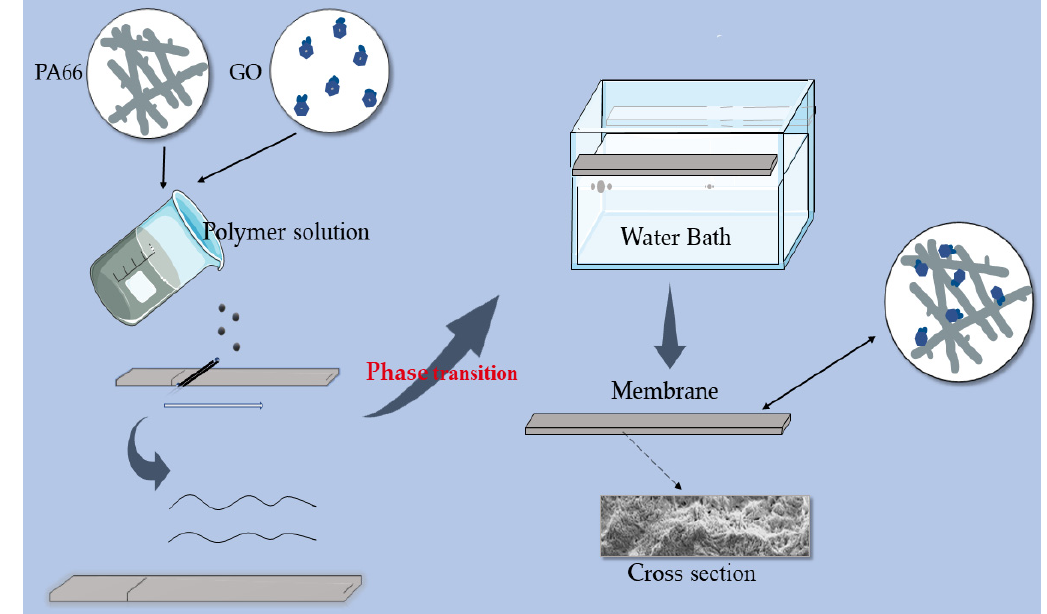
Figure 1. Schematic diagram of membrane formation mechanism.